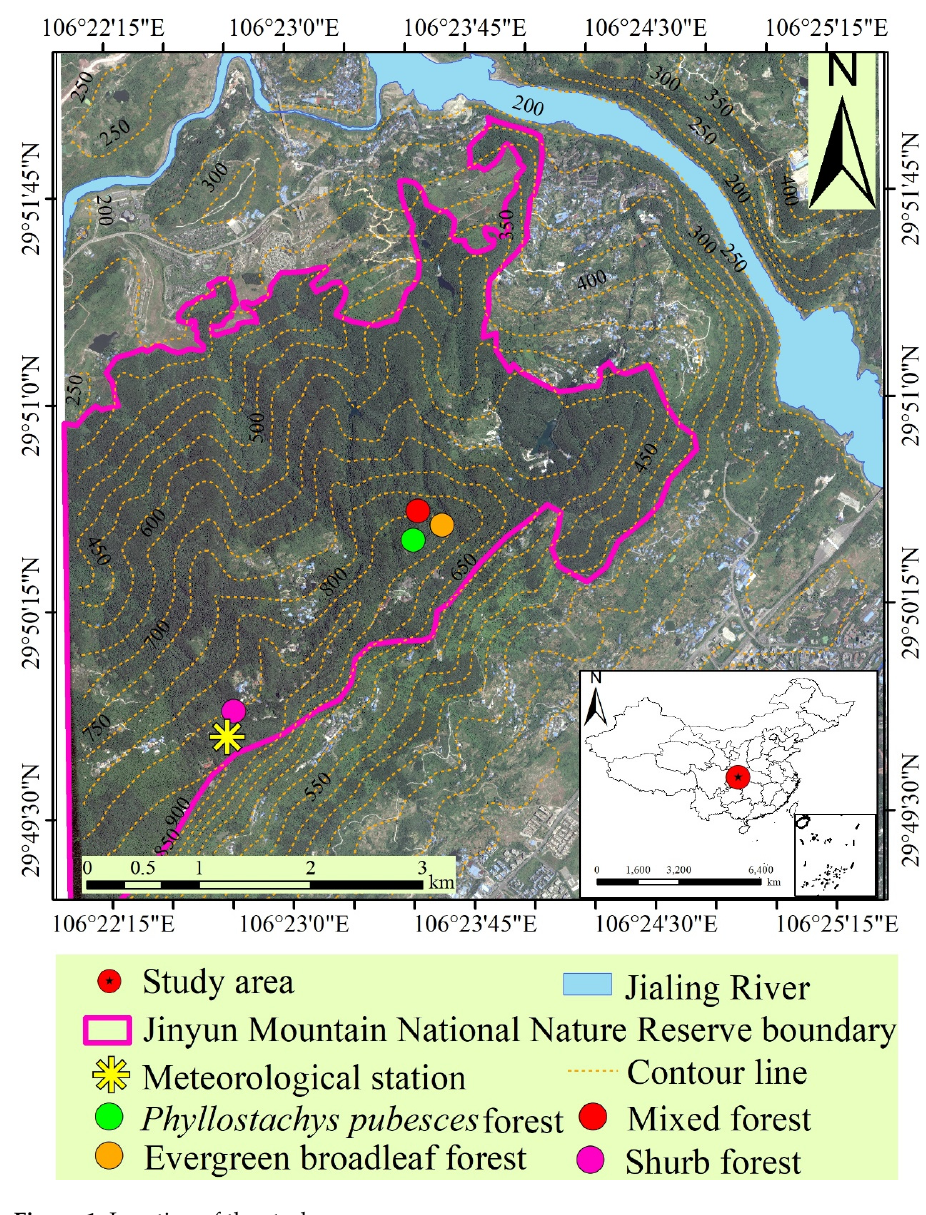
Figure 1. Location of the study area.